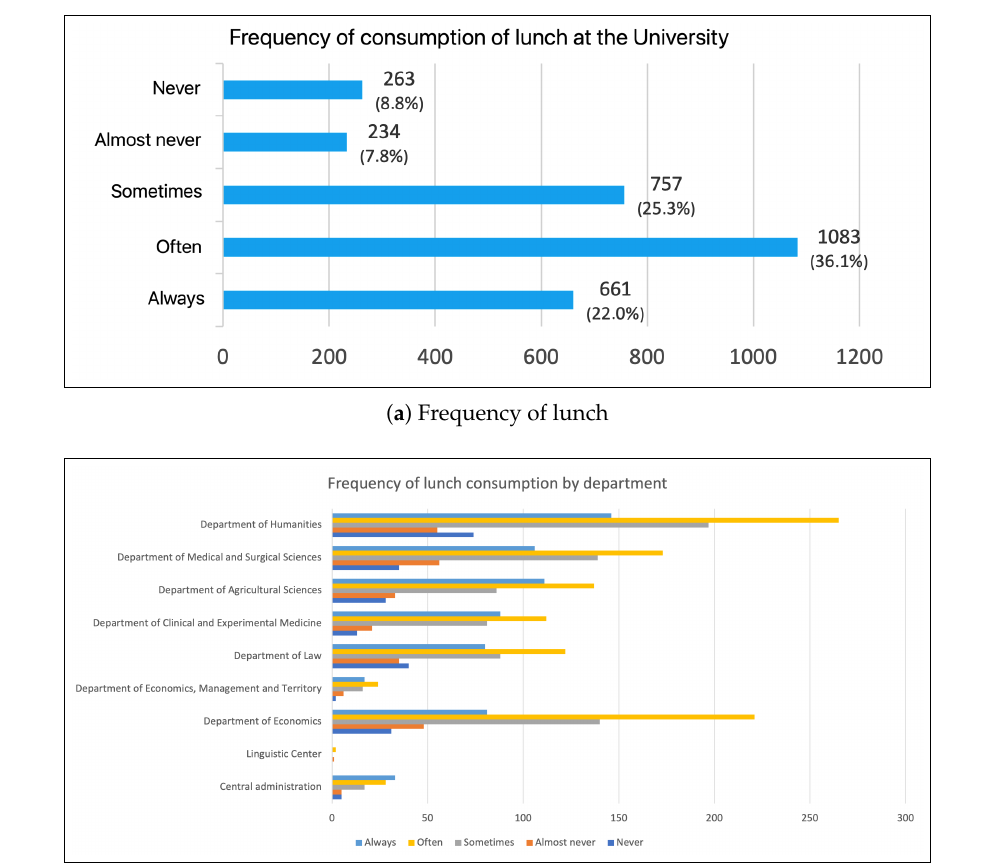
Figure 23. Sustainable mobility services required according to means of transport.